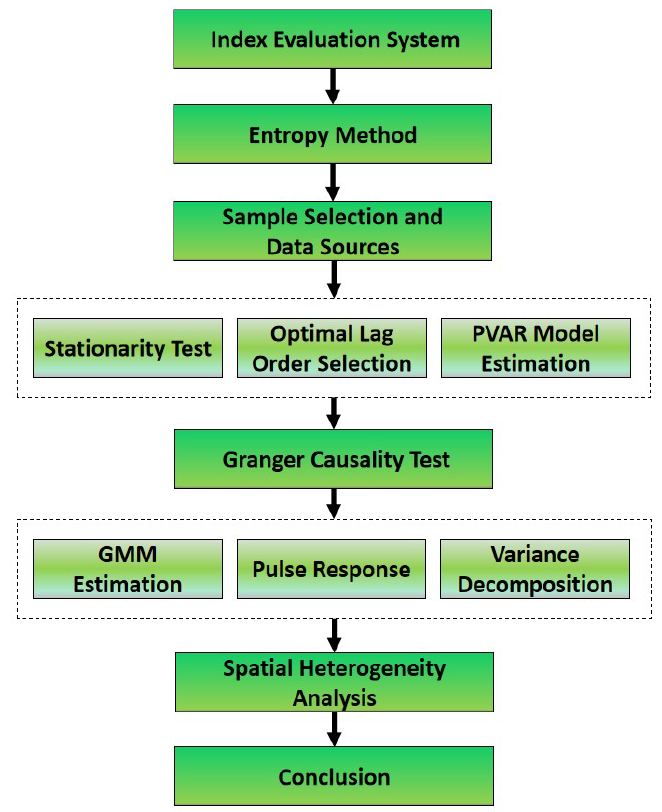
Figure 2. Research scheme of the research process (source: made by